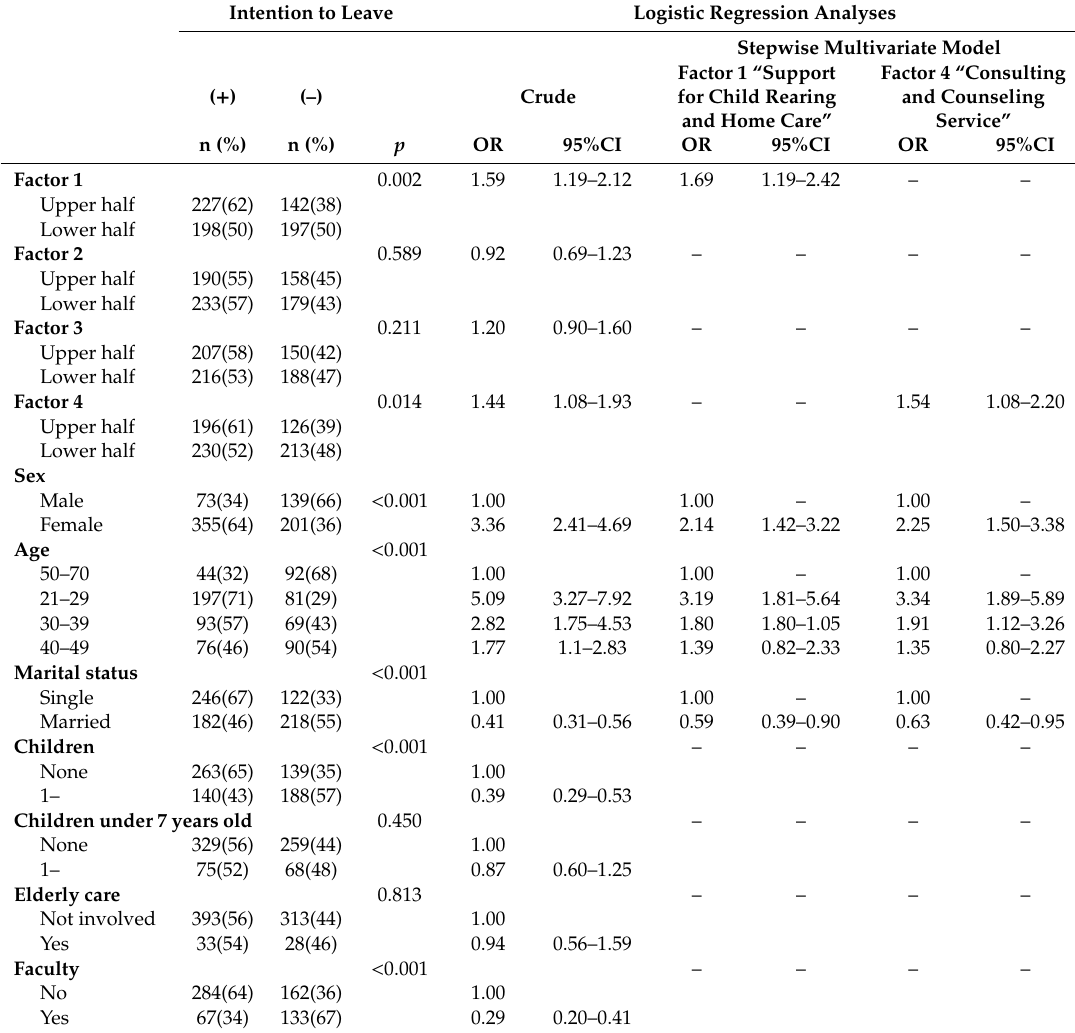
Table 4. The influence of four factors on intention to leave